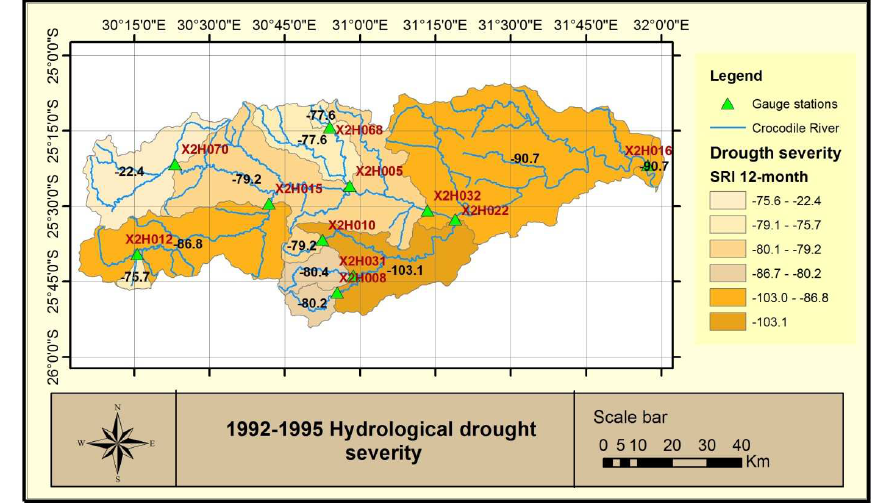
Figure 7. Spatial variability of the hydrological drought severity during the 1992–1995 drought.